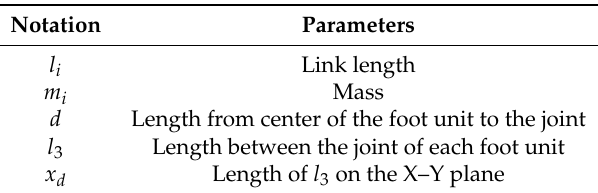
Figure 12. The schematic figure of the biped robot in three-dimensional space. Table 3. Physical Parameters. ( i =